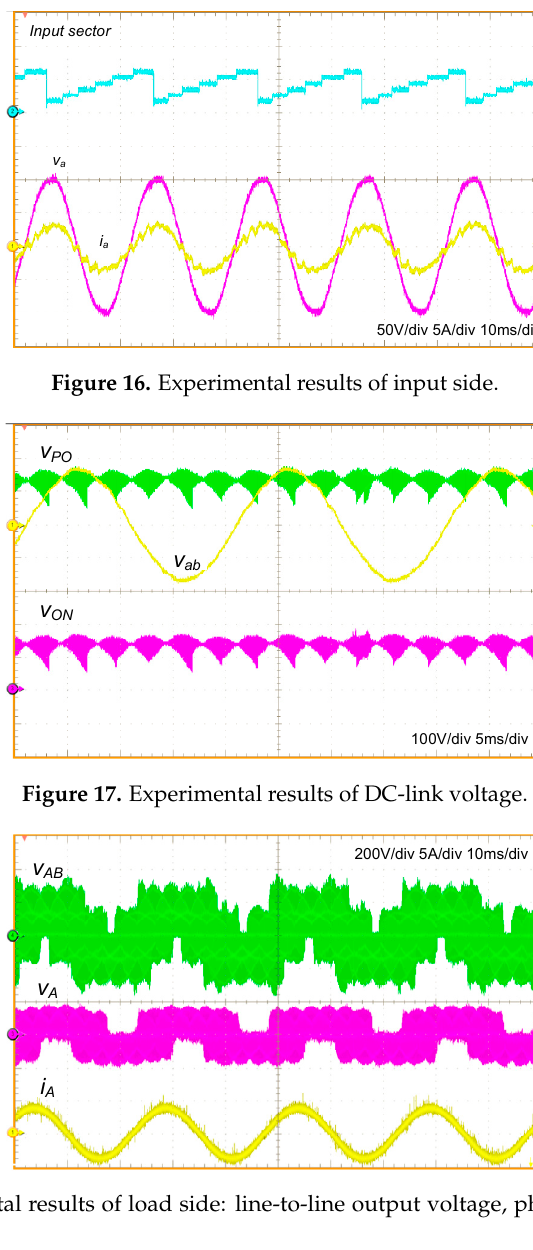
Figure 15. The zoom-in of PWM signals of rectifier and inverter stages.